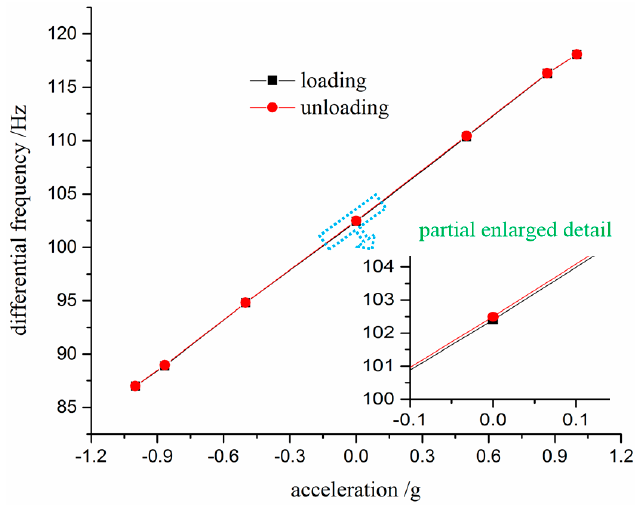
Figure 19. Loading and unloading process.